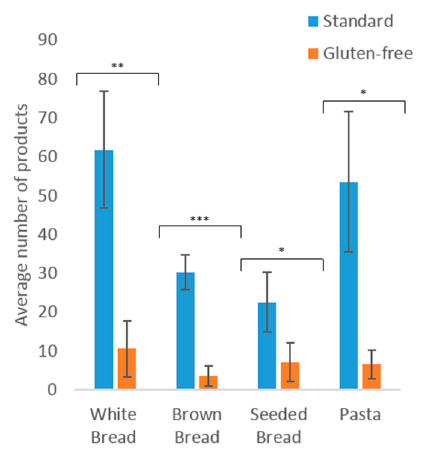
Figure 1. The average number of standard and gluten-free products available in four major UK supermarket websites. Key: * = p < 0.05, ** = p < 0.01, *** = p < 0.001.